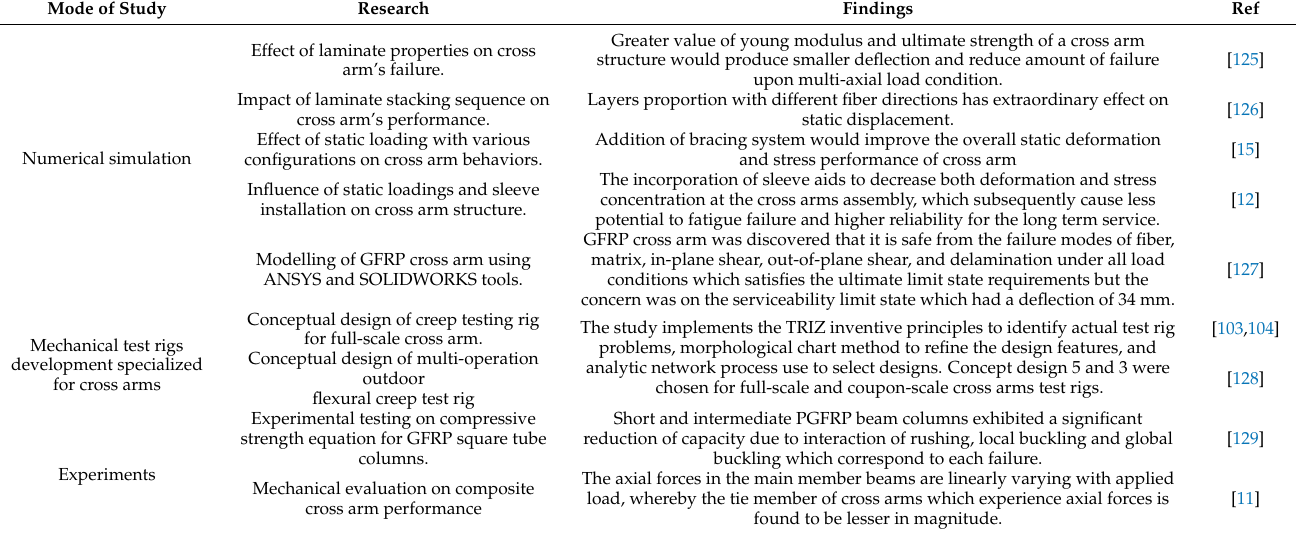
Table 2. Current research progresses of pultruded glass fiber-reinforced polymer composite (PGFRPC) cross arm studies. Mode of